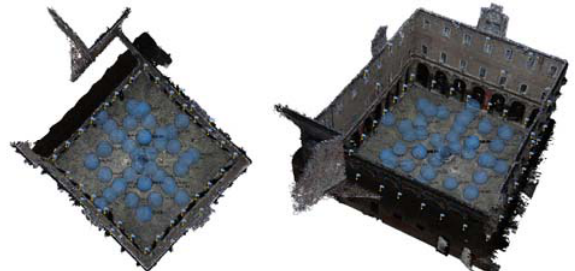
Figure 7. The first photogrammetric model created with the GCPs in the bundle adjustment